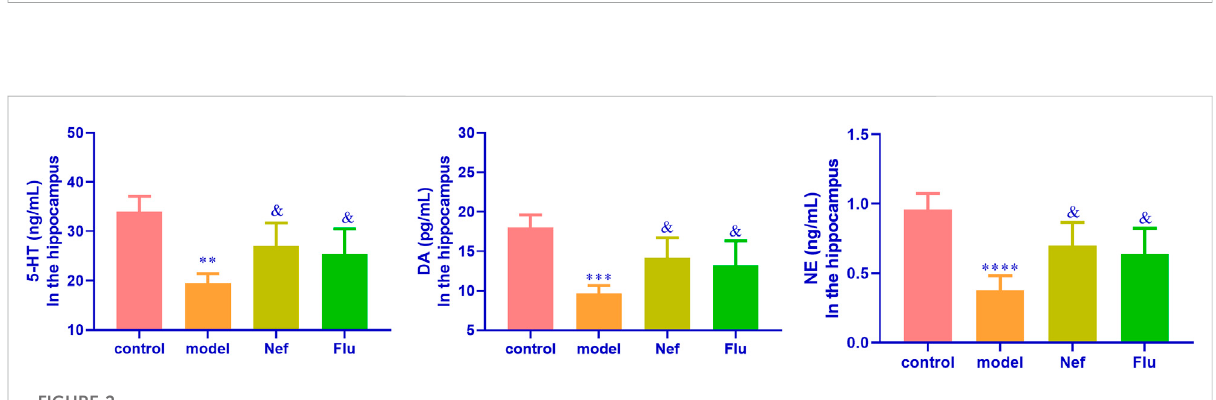
Hippocampal expression of anti-depression factors in depressed mice restored by Nef treatment. DA, dopamine; 5-HT, serotonin; NE, norepinephrine;Nef,neferine;Flu, fl uoxetine.NefandFlubothincreasedthelevelsofDA,5-HT,andNEinthehippocampusofdepressedmice.Data are presented as mean ± standard deviation (SD; n = 5 per group). ** p < 0.01, *** p < 0.001, **** p < 0.0001 vs control; & p < 0.05 vs